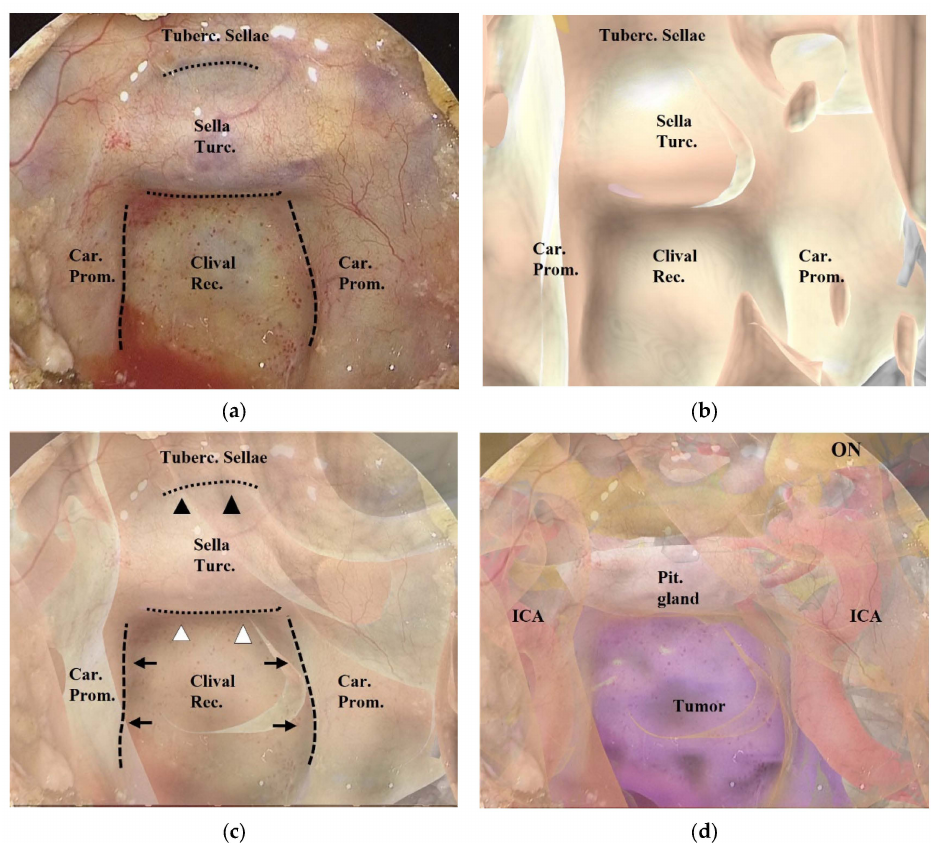
Figure 2. Procedure for superimposing the 3DCG model on the neuroendoscopic image. ( a ) Endo- scopic image in the sphenoid sinus. The dashed lines indicate the inner lines of the bilateral carotid prominences, and the dotted lines indicate the inferior line of the tuberculum sellae and the sellar floor. ( b ) 3DCG model in the sphenoid sinus. ( c ) Fusion image created by superimposing the 3DCG model ( b ) on the endoscopic image ( a ). The inner lines of the bilateral carotid prominences (black arrows) were aligned with the dashed lines, and the 3DCG was tilted to align the sellar floor (white arrowheads) and the tuberculum sellae (black arrowheads) with the dotted lines. ( d ) Fusion image with intracranial structures displayed in the 3DCG model. Tuberc., tuberculum; Rec., recess; Turc., turcica; Car., carotid; Prom., prominence; Pit., pituitary; ON, optic nerve; ICA, intracranial artery.